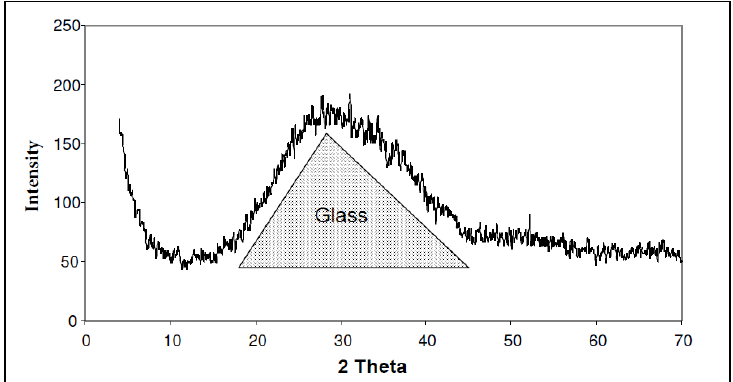
Figure 3. X-ray diffractogram of the glass powder of d50 = 16 μm. The dotted area shows the bulging of the baseline indicating the presence of amorphous phases [32].